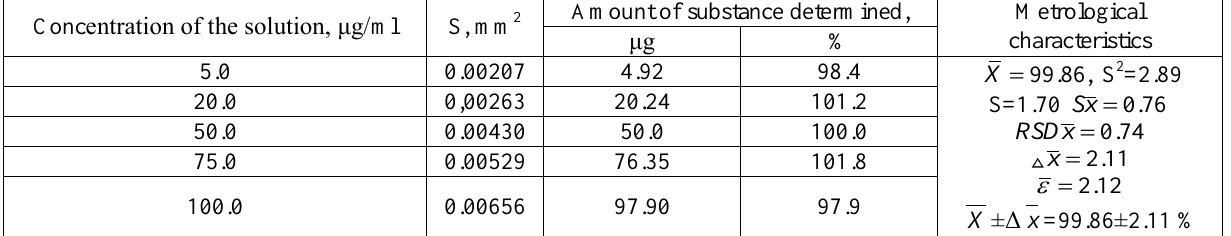
Results of quantitative determination of clonidine hydrochloride in model solutions by HPLC method (n=5, Р =95 %) Concentration of the solution,